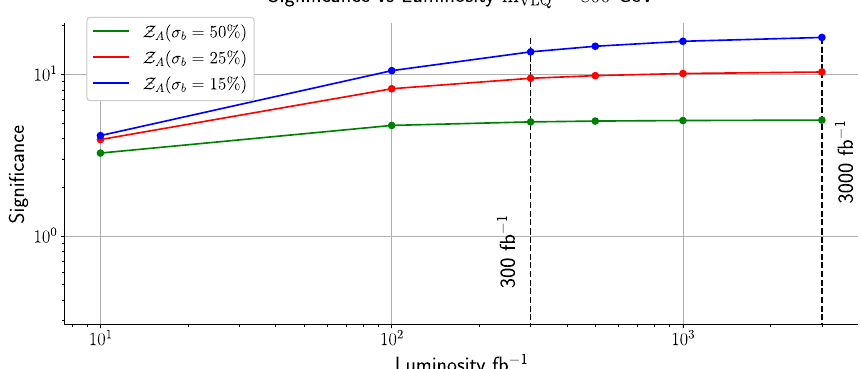
lowing the implementation of an evolution algorithm whose method is described in [24]. From left to right, we have σ b = 15%, σ b = 25% and σ b = 50%